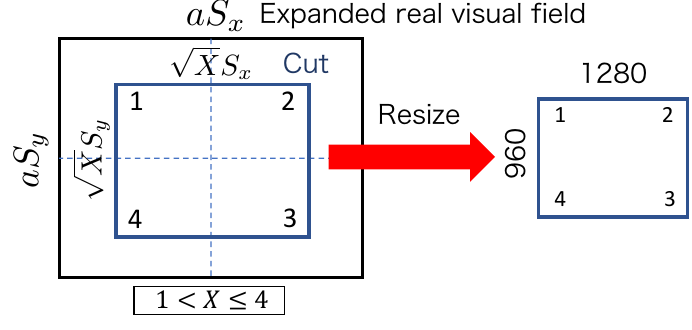
Figure 13. Resizing procedure for HMD.